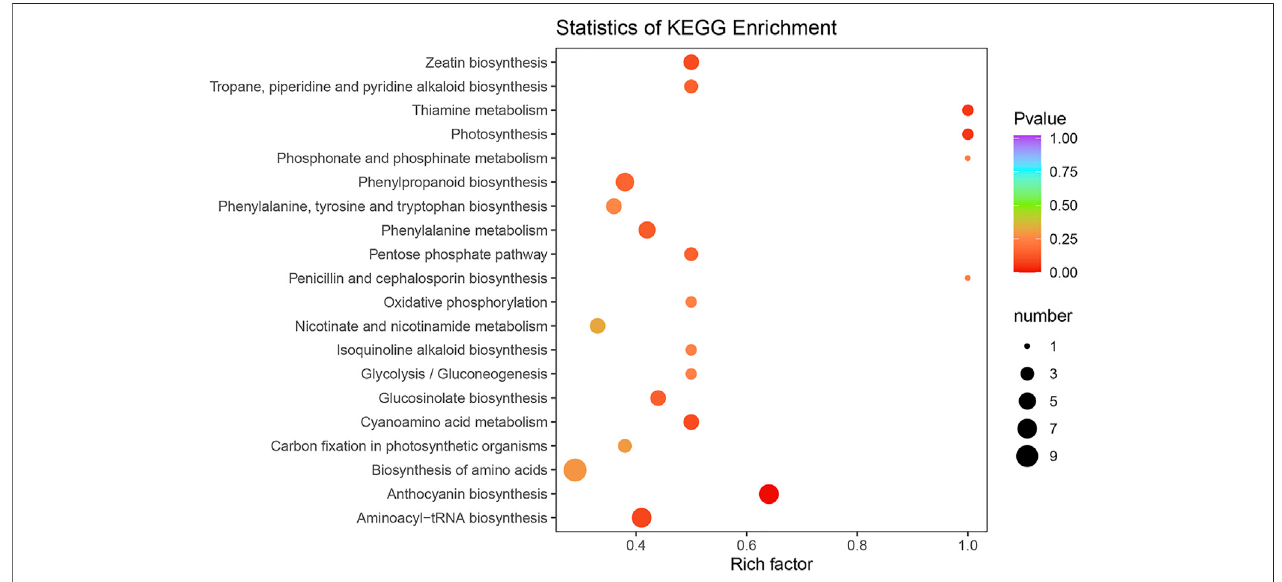
FIGURE 6 | KEGG classi fi cation of DEMs between the SFs and PFs of mulberry. The color of the balls indicates the p value of the KEGG enrichment analysis, red indicates the highest p value and blue the lowest (least likely to occur by chance), and the size of the ball represents the number of metabolites enriched in the pathway.